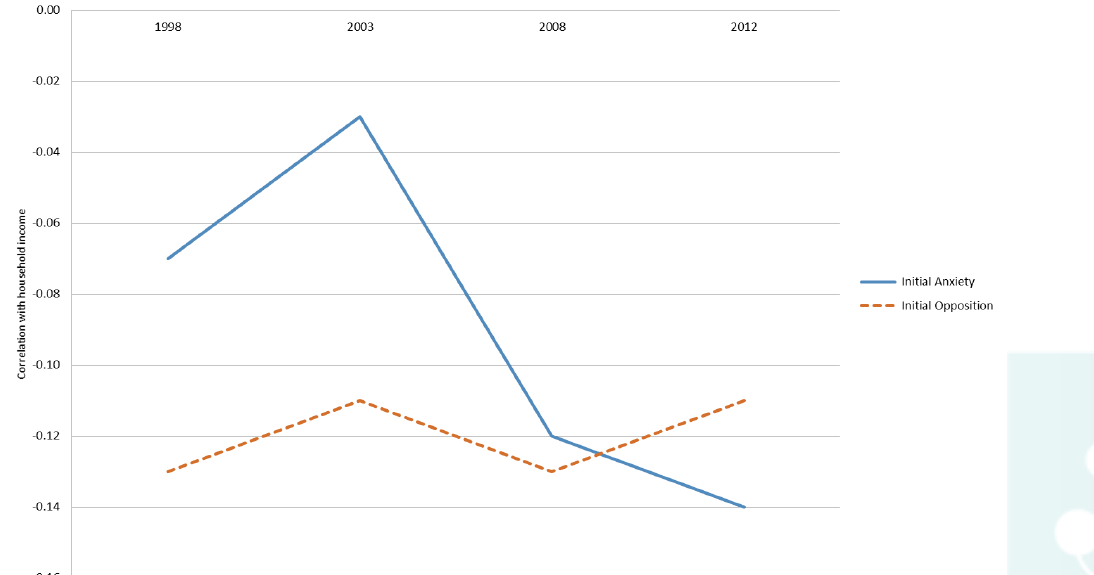
Figure 2: Household income and childhood